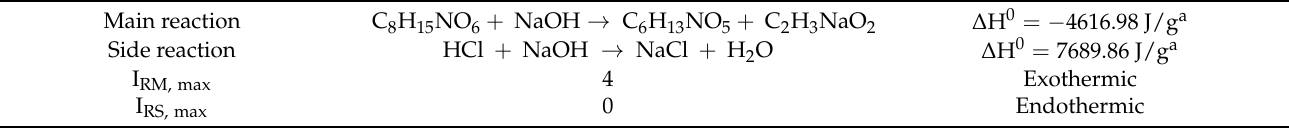
Table 2. Heats of reaction for deacetylation and neutralization stages in chitosan production from shrimp shells Main